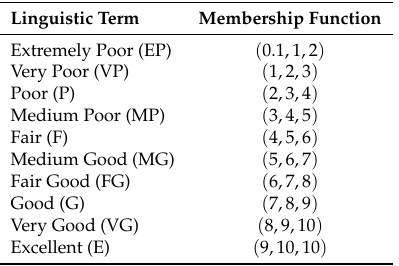
Table 2. Linguistic terms and membership functions of fuzzy